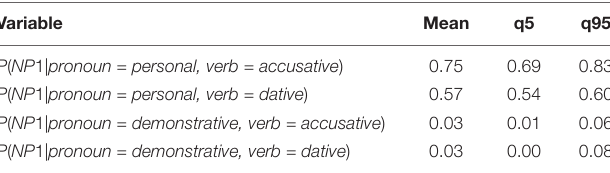
TABLE 4 | Value of P ( NP 1) across verb type and pronoun type for the Mirror model, Experiment 1.